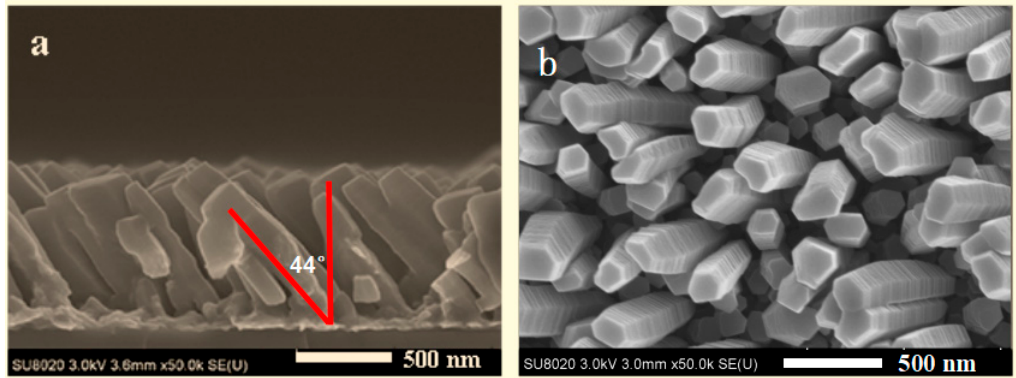
Figure 5. SEM ( a ) cross-section view and ( b ) surface view of a Mg nanostructured thin film synthesized for α = 85° and P Tot =0.26 Pa.